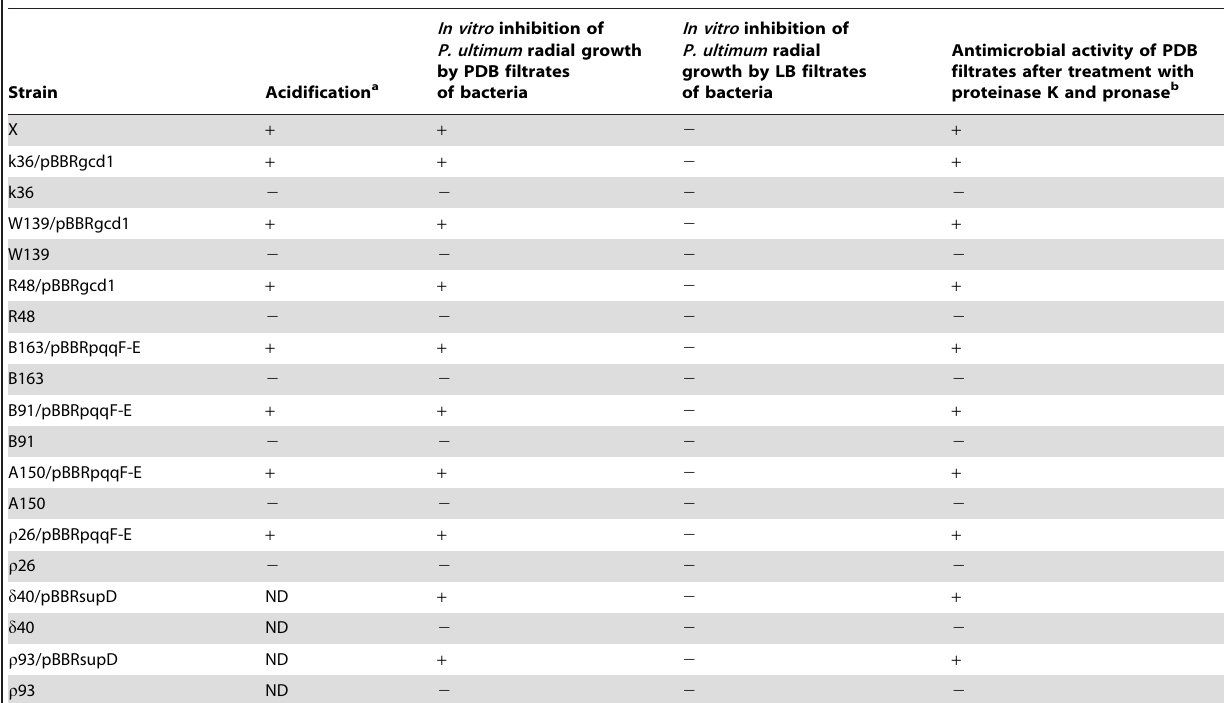
Table 1. Characteristics of sup 2 mutants and complementation analysis.